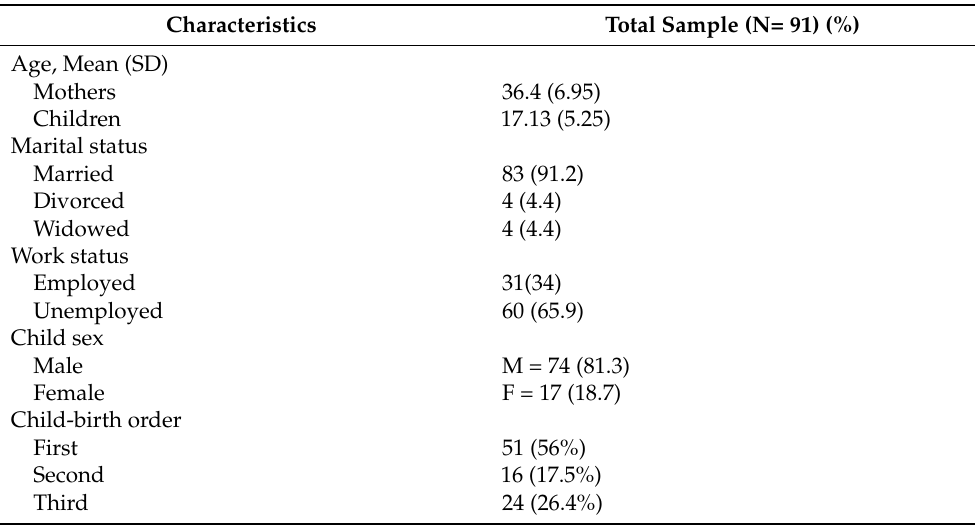
Table 1. Demographic data of the